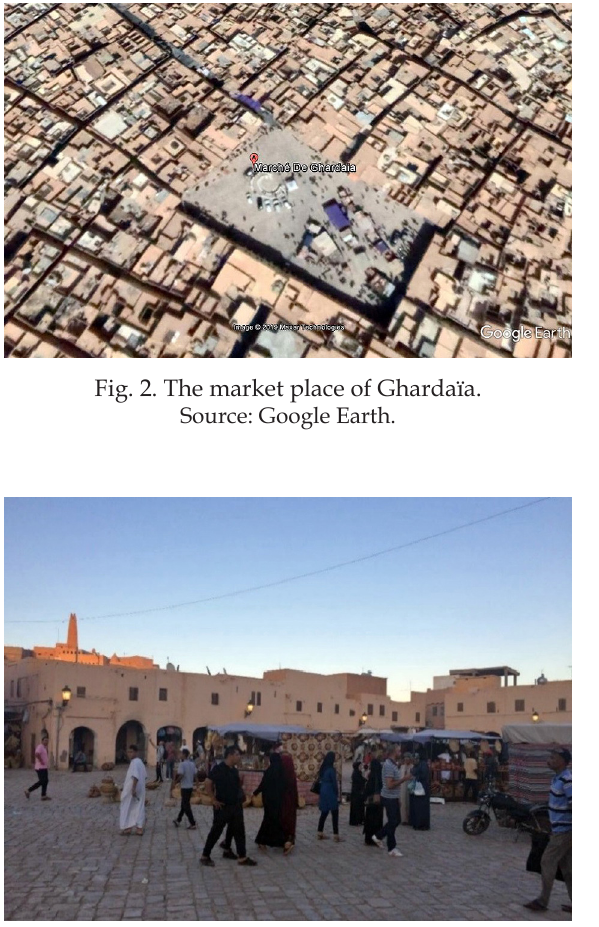
Fig. 3. The market place of Ghardaïa taken around the end of the